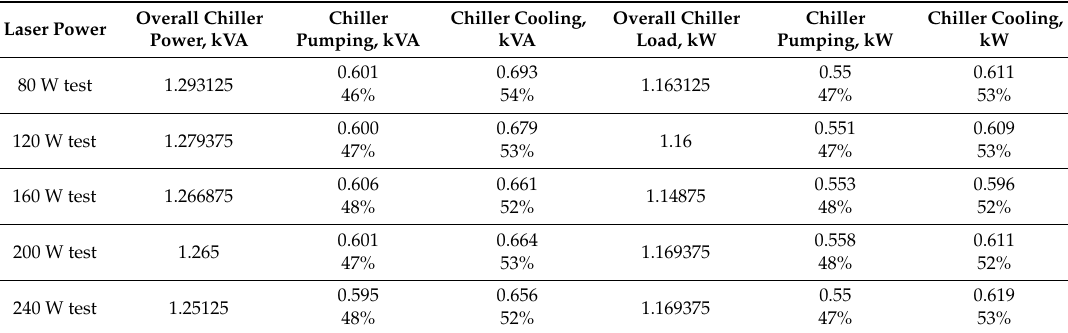
Table 7. Chiller power measurements at different laser power levels.